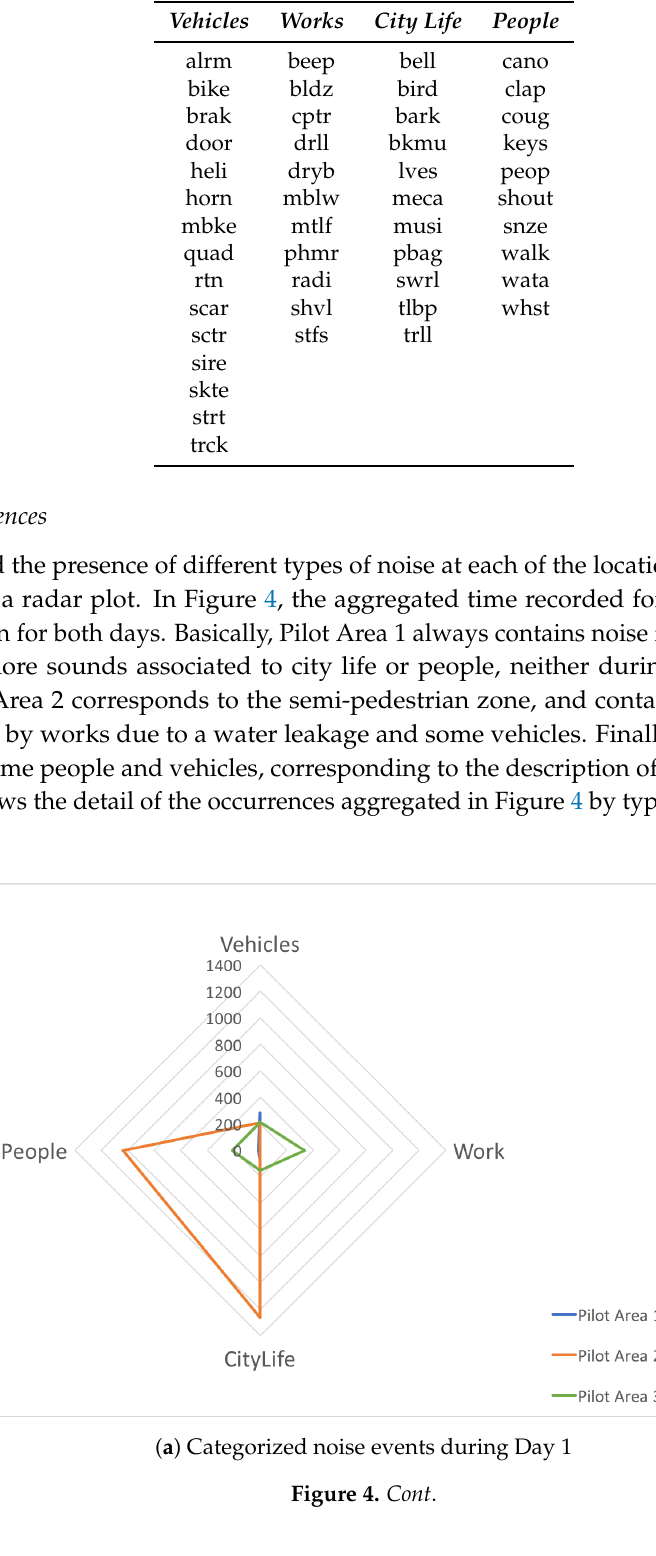
Table 1. All labels used at least once during the post-processing stage. Noise Events Category List Vehicles Works City Life People alrm beep bell cano bike bldz bird clap brak cptr bark coug door drll bkmu keys